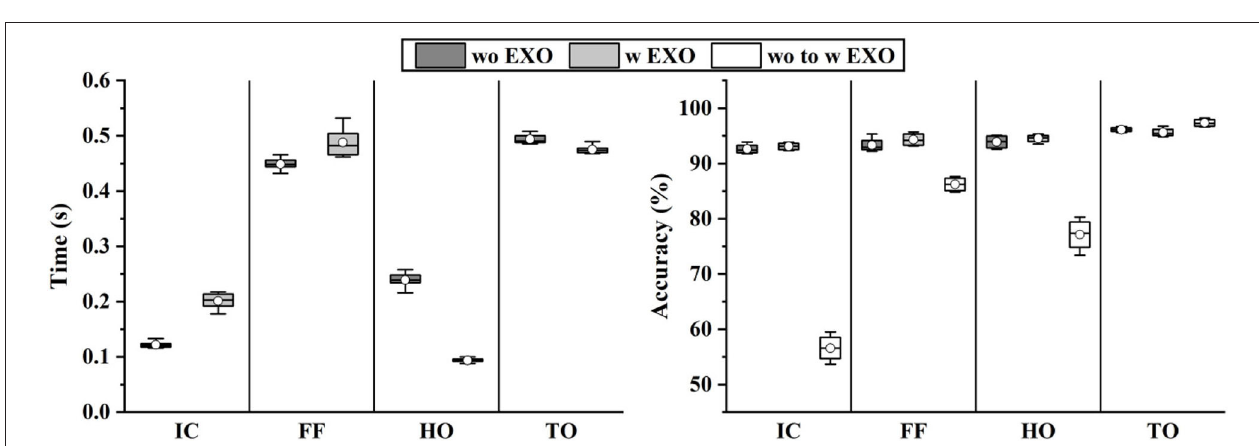
FIGURE 10 | The duration and phase classification results involving the